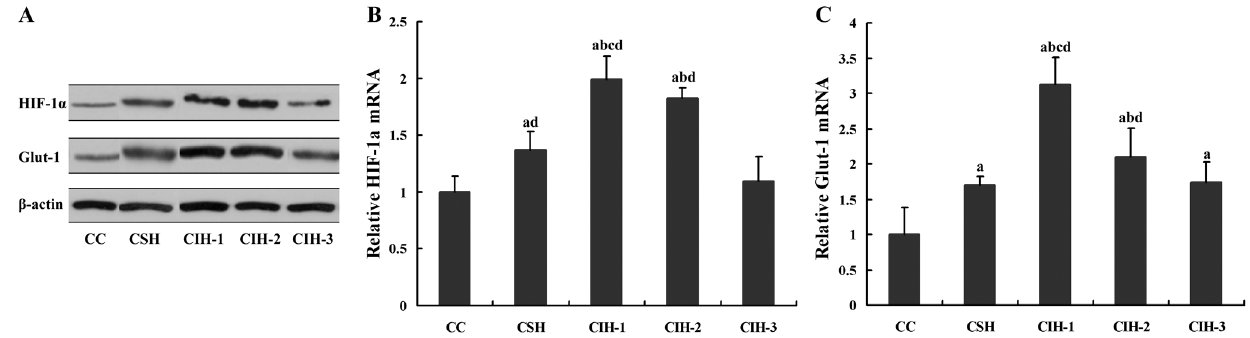
Figure 3. Effects of IH on mRNA and protein levels of HIF-1 a and Glut-1 in cellular model. a P , 0.05 compared with CC group; b P , 0.05 compared with CSH; c P , 0.05 compared with CIH-2, d P , 0.05 compared with CIH-3. Note: HIF-1 a , hypoxia-inducible factor-1 a ; Glut-1, glucose